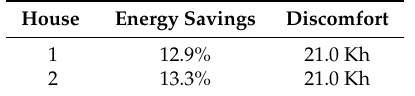
Table 16. Results for Case 2B.